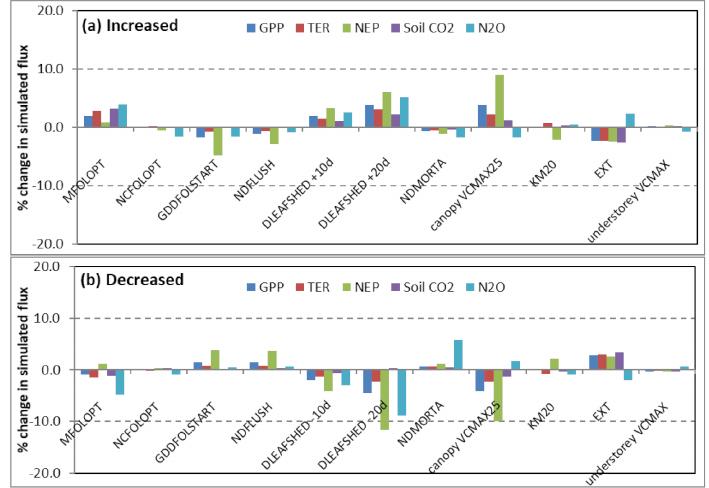
Figure 8. Sensitivity tests showing % change in simulated annual CO 2 and N 2 O fluxes with chosen PSIM module parameter values ( a ) increased by 10% and ( b ) decreased by 10% (except DLEAFSHED: changed by 10 days and 20